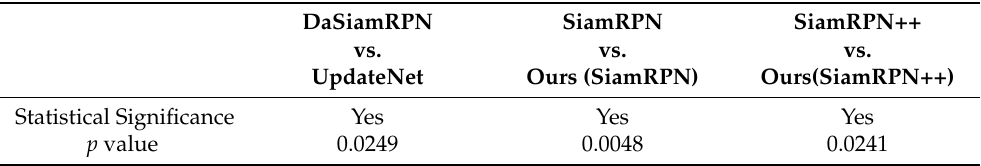
Table 2. Statistical significance of three comparative approaches.